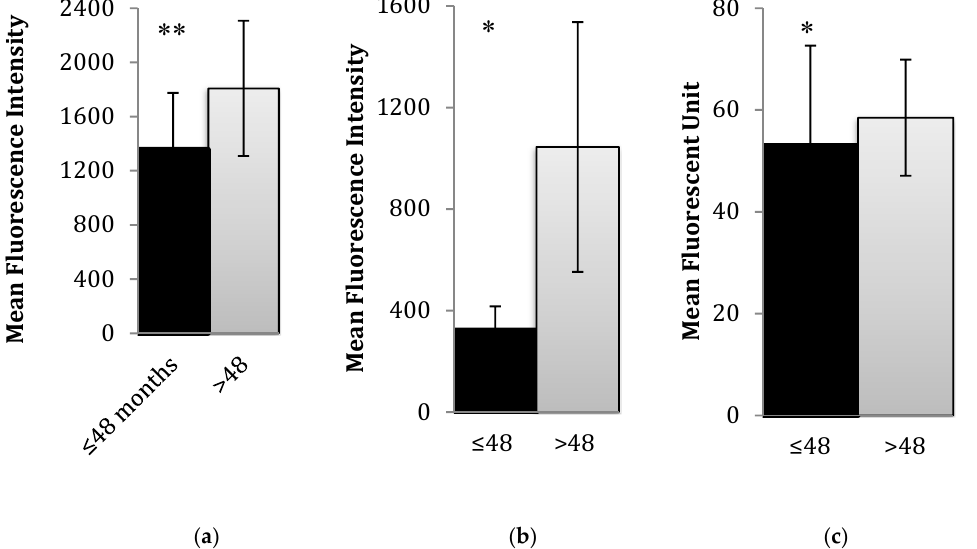
Figure 2. Redox differences in peripheral blood cells collected at baseline between the younger ( ≤ 48 months) and older ( > 48 months) group. Oxidative stress levels were significantly different between the older and younger group for all measures including ( a ) hydrogen peroxide measured by dichlorodihydrofluorescein (DCF) fluorescence, ( b ) superoxide measured by hydroethidine (HE) fluorescence, and ( c ) glutathione measured by monochlorobimane (mBCI) fluorescence. Mean fluorescent intensity (MFI) for each of these dyes is shown on the y axis of each graph. Peripheral